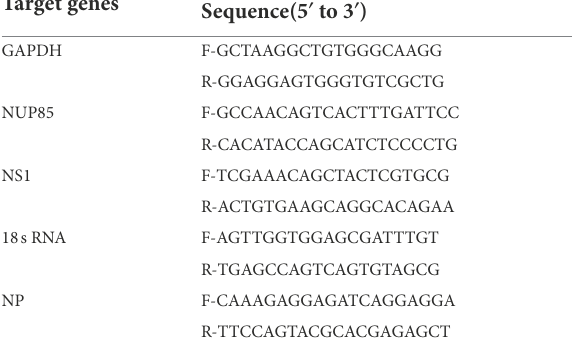
TABLE 3 List of primers for qRT-PCR assay in this